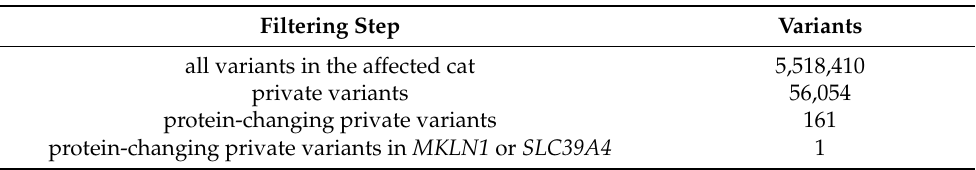
Table 1. Results of variant filtering in the affected Turkish Van cat against 54 control genomes. Only homozygous variants are reported.